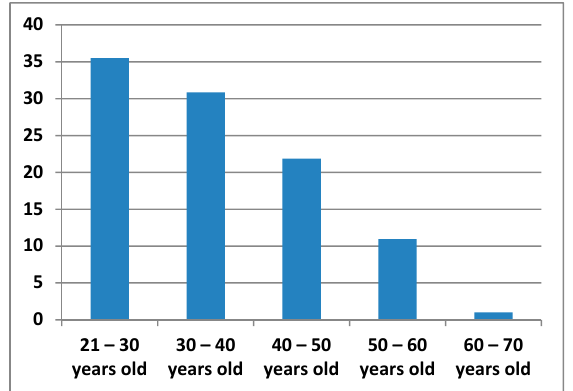
Figure 2. Percentage of age groups.